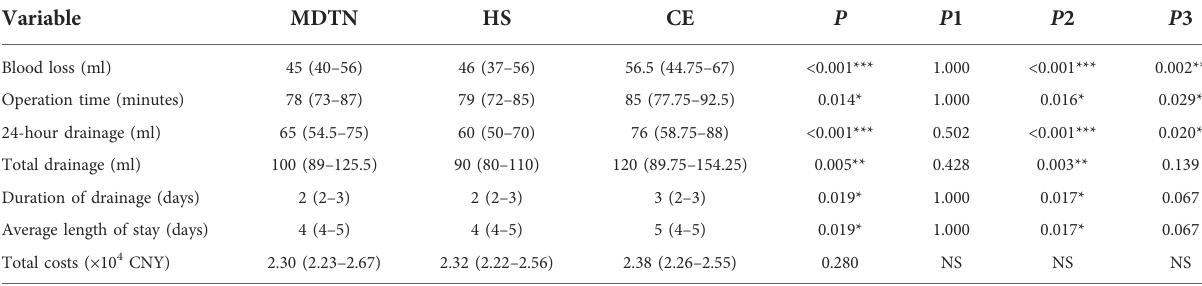
TABLE 2 Surgical ef fi cacy comparison of the three groups.